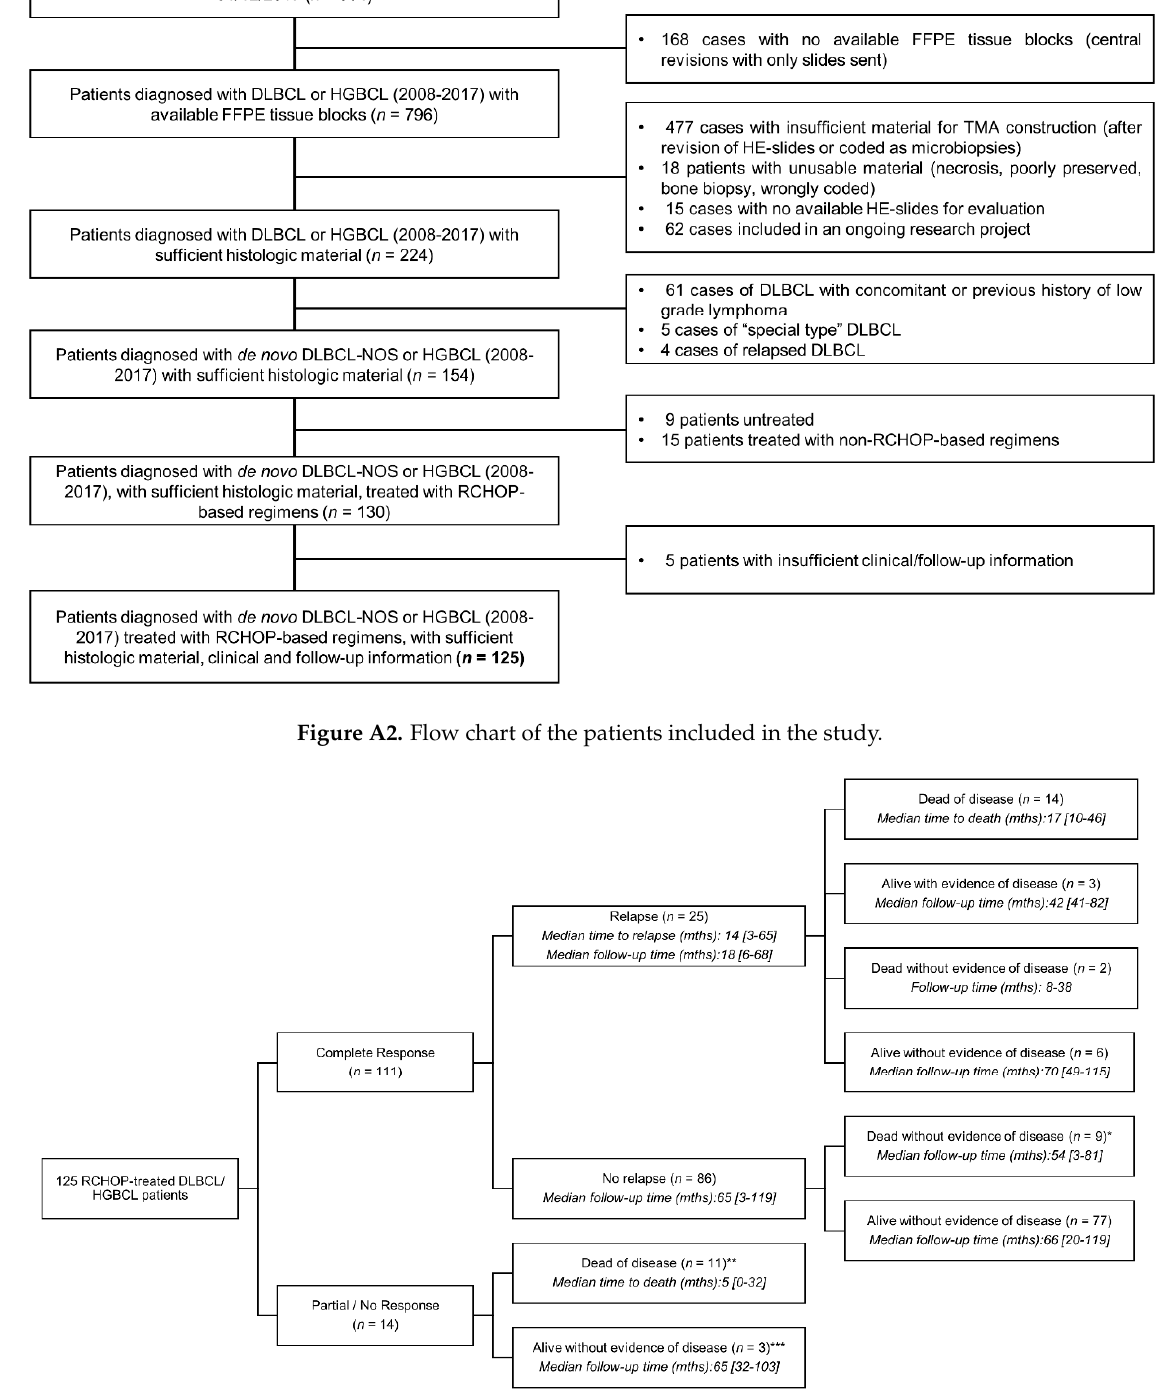
Figure A3. Response, outcome and follow up diagram of the 125 RCHOP-treated DLBCL/HGBCL patients included in the study. * includes 1 patient who died within the first 3 months after treatment (considered as dead of disease for statistical analysis purposes); ** includes 2 patients who underwent treatment changes at months 2 and 3 after diagnosis; *** all patients underwent treatment changes at months 1, 2 and 3 after diagnosis. RCHOP, Rituximab, cyclophosphamide, doxorubicin, vincristine, prednisone DLBCL, Diffuse large B-cell lymphoma; HGBC, High grade B-cell lymphoma; mths,